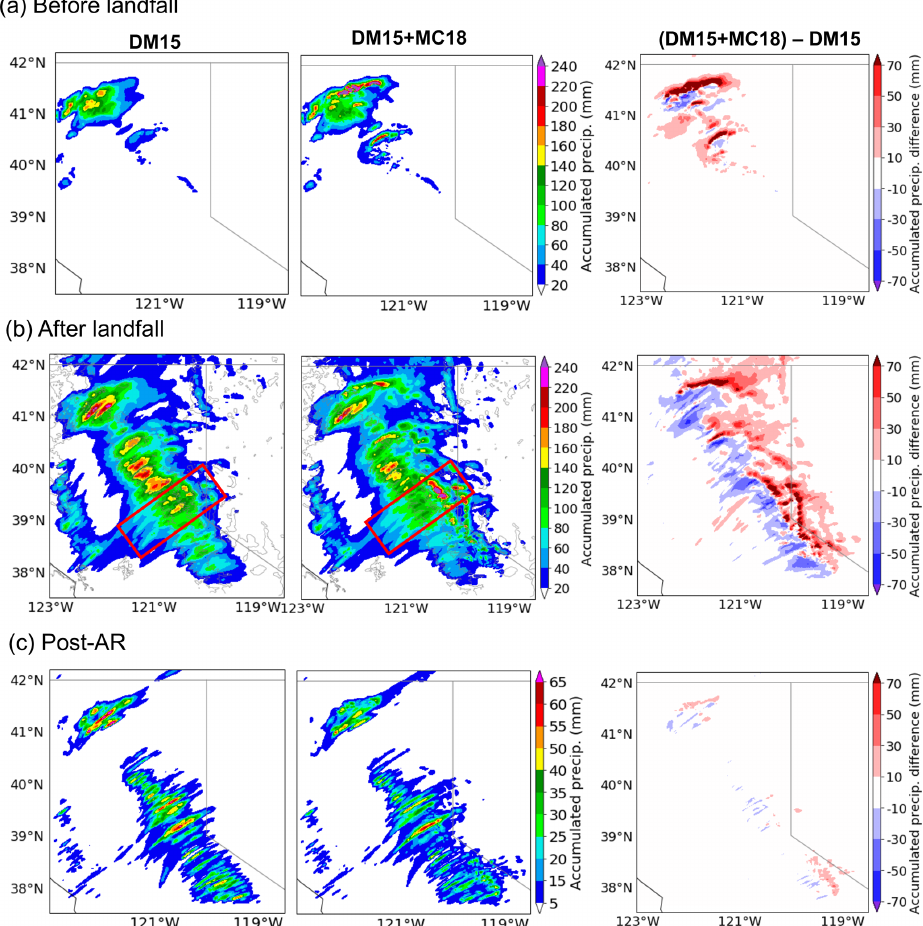
Figure 8. Spatial distribution of accumulated precipitation during the stages (a) before AR landfall, (b) after AR landfall, and (c) post-AR in DM15 (left), DM15 + MC18 (middle), and the difference between DM15 + MC18 and DM15 (right). The rectangles marked in (b) denote the area for the east–west cross-sectional analysis shown in Fig.